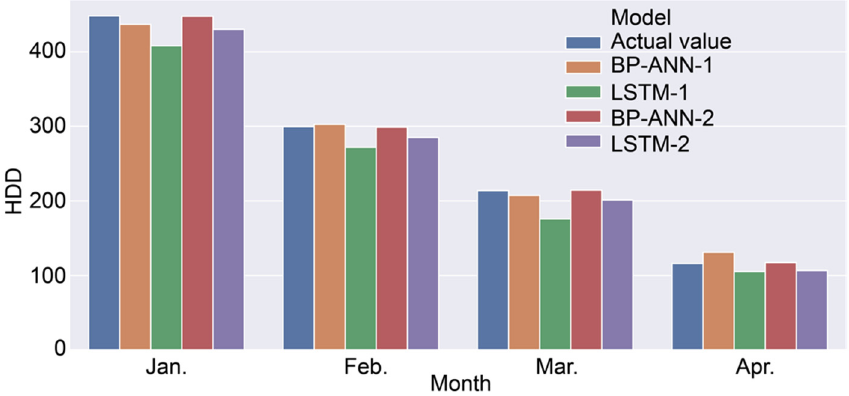
Figure 8. The comparison between HDD results using BP-ANN and LSTM techniques in Model 1 and